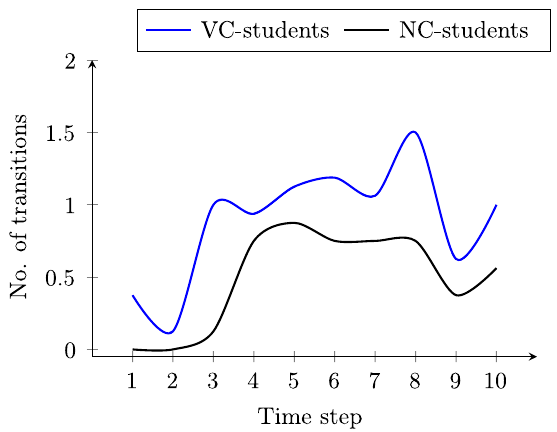
FIG. 6. Average transitions between the strategy and the diagram per student over time by group condition.